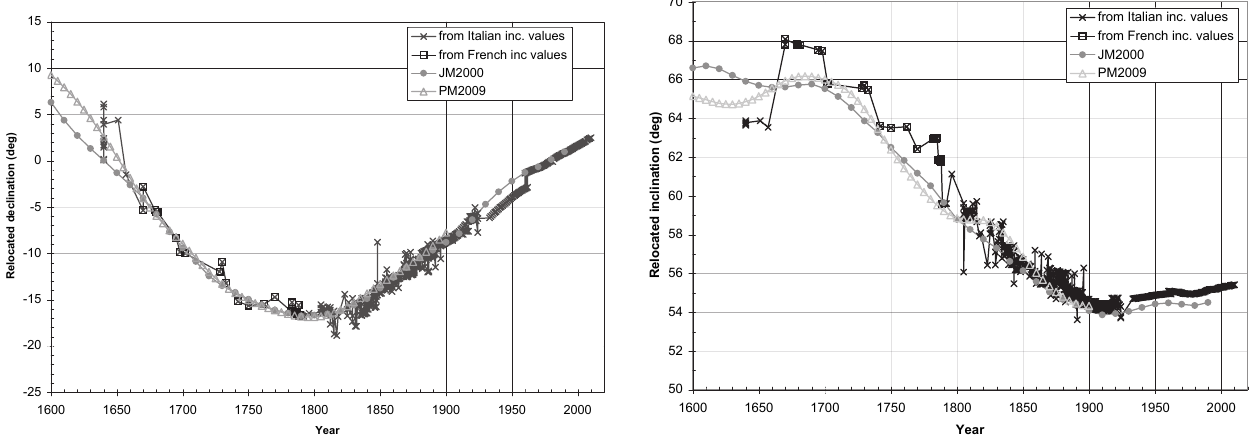
Fig. 2. Italian geomagnetic observations relocated to Stromboli (38.8 ◦ N, 15.2 ◦ E) via the pole method, along with 1600–1990 (and 1600– 1900) directions derived for Stromboli from JM2000 (and PM2009) models. Italian declinations gathered between 1670 and 1789 were relocated using coeval French geomagnetic observations (Alexandrescu et al.,